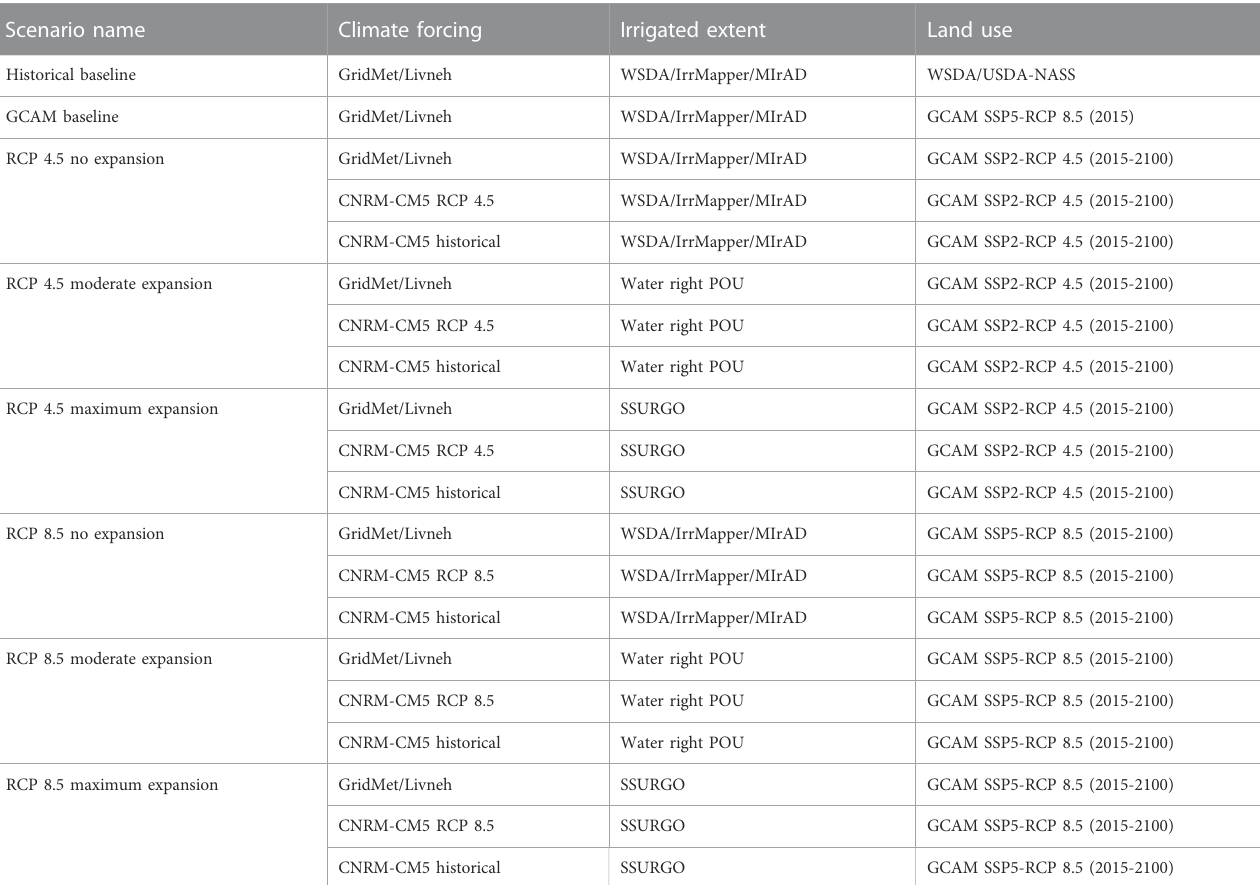
TABLE1Scenarioimplementation.Therearetwobaselinescenarioswhichassumehistoricalclimate,irrigatedextent,andlanduse.Theremainingsixscenariosassume combinations of three irrigation levels and two LULCC scenarios from GCAM over the period 2015-2100. Each of these scenarios was forced by an observed historical (GridMet/Livneh), modeled historical (CNRM-CM5 historical), and modeled future (CNRM-CM5 RCP 4.5/RCP 8.5) climate